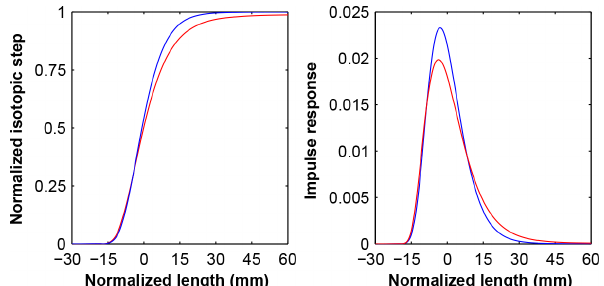
Figure 4. The log–log CDF transfer functions (left) and skew- normal impulse response functions (right) of the CRDS-CFA sys- tem for δ D (red) and δ 18 O (blue). The normalized functions are fit- ted to a mock ice isotopic step change in δ D of approximately − 240 to − 120‰. The normalized length scale is calculated using an av- erage melt rate of 2.5cmmin − 1 . Note that the impulse response of δ D is slightly wider than for δ 18 O, which could possibly arise from diffusional effects in the system, differing interactions of wa- ter molecules with the Picarro filters, and differing memory effects within the Picarro